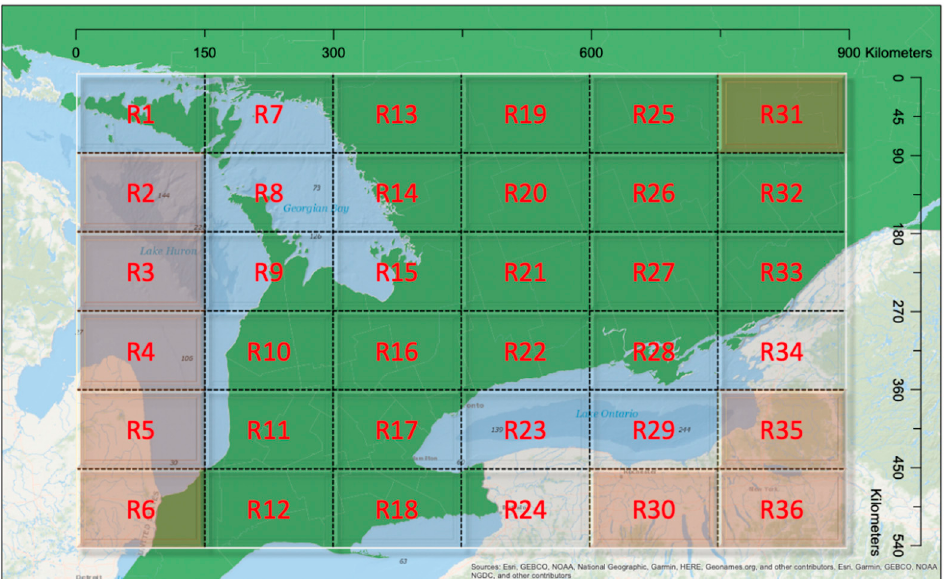
Figure 3. Study area partitioning. Sample locations are grouped into 36 regions to capture the random effects in the second model. Please note that there were no data in Regions R2, R3, R4, R5, R6, R30, R31, R35, and R36 and these regions were excluded from the model.